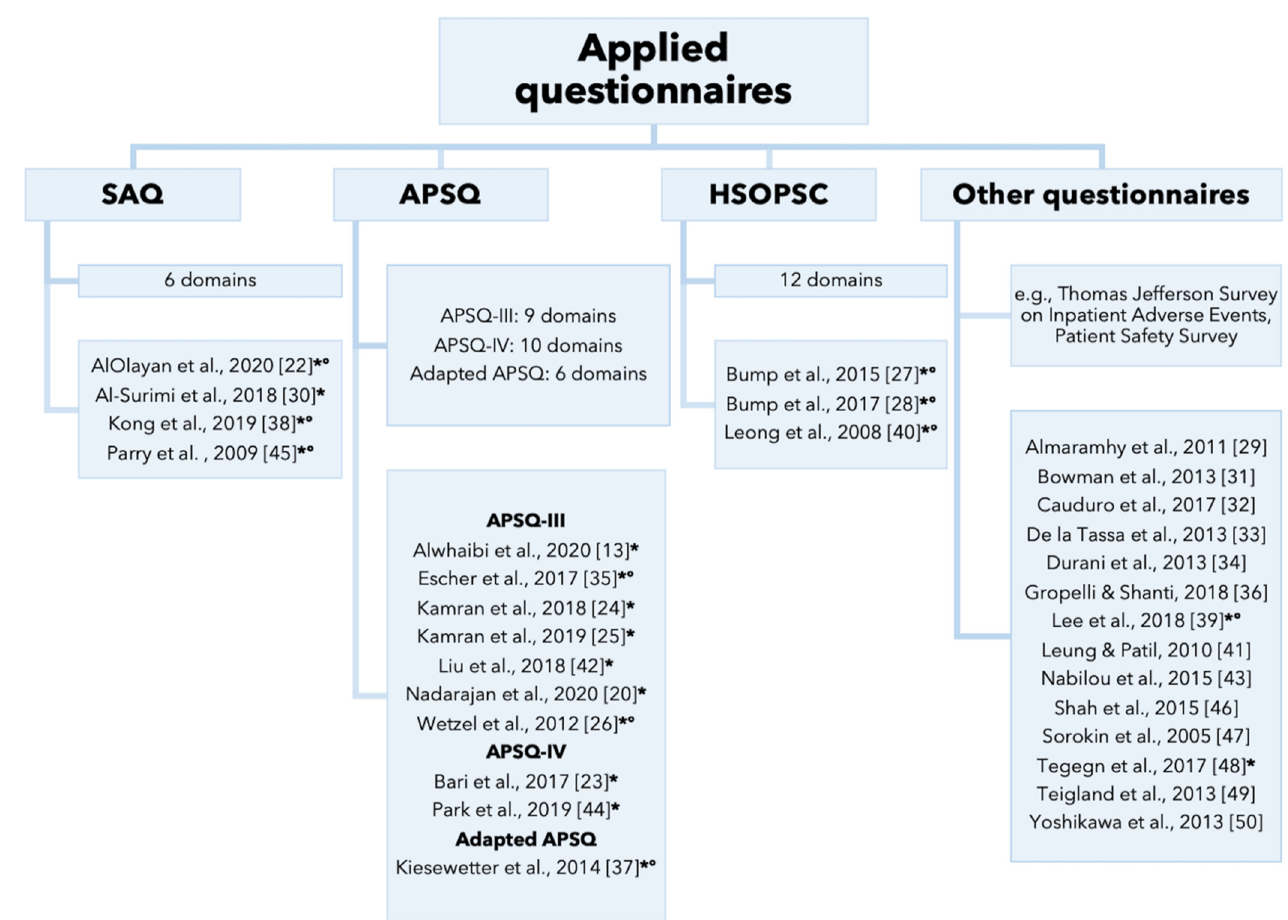
Figure 1. Different types of questionnaires used in the studies. Notes. * Use of questionnaire validated in original language; ◦ Use of questionnaire validated in language in which it was administered.